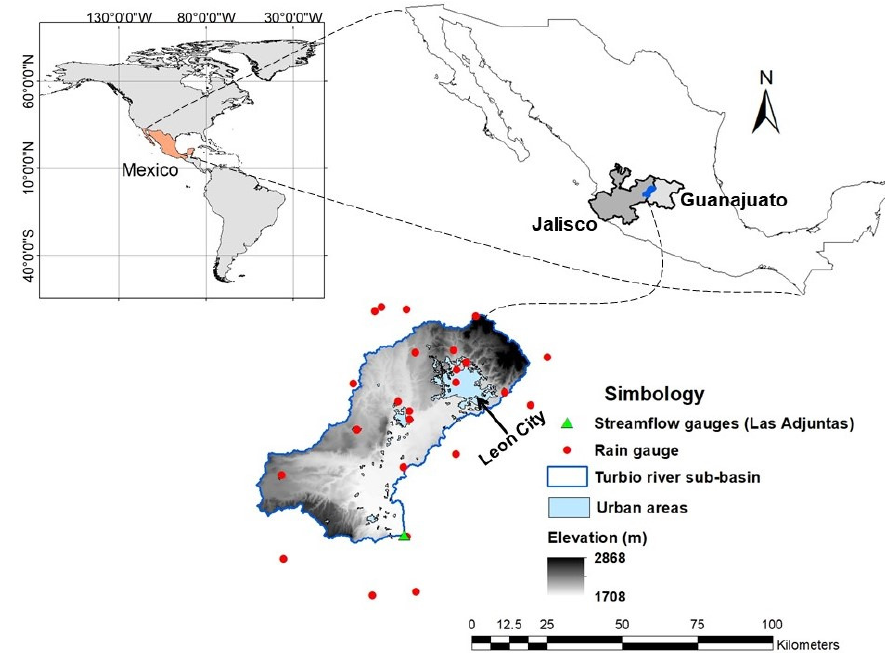
Figure 3. Location of the Turbio River sub-basin used as a study area including the rain gauges ( ◦ ) and stream-flow gauge ( ∆